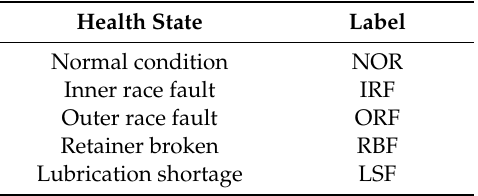
Table 8. Health states of the rolling bearing in Case Two.